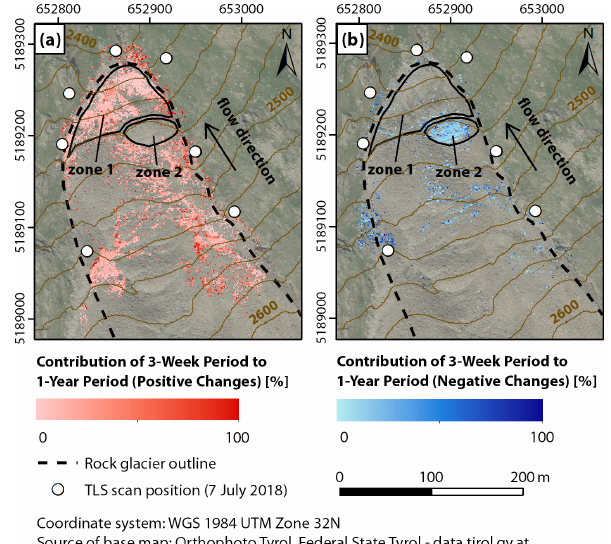
Figure 7. Percentage contribution of the 3-week period to the an- nual surface change. Active zone 1 comprises the rock glacier front, and active zone 2 represents a ridge above the rock glacier front ex- hibiting negative surface change in both periods. Panel (a) shows positive changes, and panel (b) shows negative